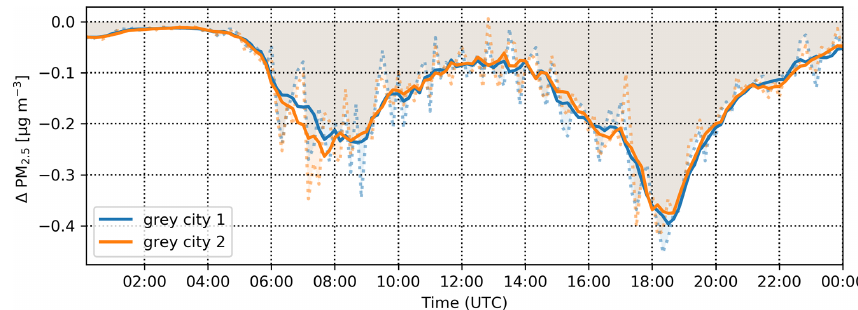
Figure 13. Differences in PM 2 . 5 in the Komunard˚u street for a grey-city scenarios SB10 (blue) and SB11 (orange). Dotted lines: 10min values; solid lines: 1h moving